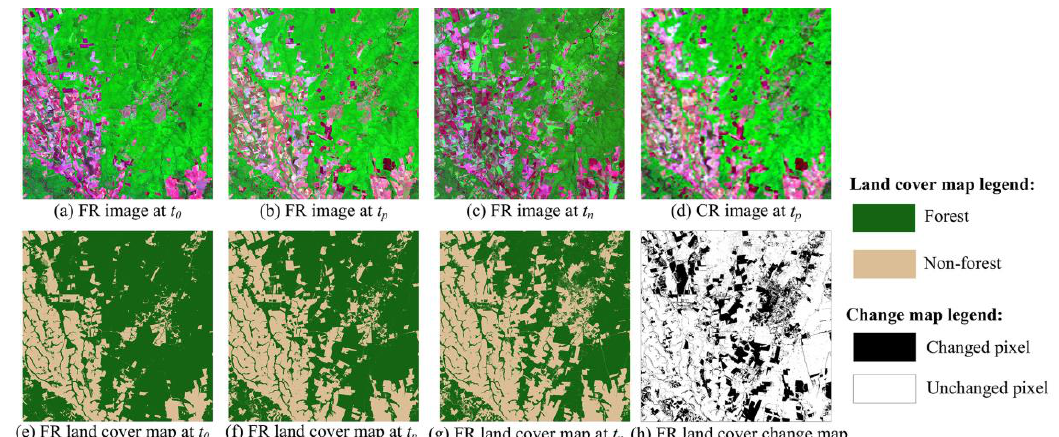
Figure 5. The FR images, CR image, FR land cover maps, and FR land cover change map used in the forest clearance experiment. The scale factor s was 16. ( a ) FR image at t 0 from Landsat image acquired on 23 July 2001; ( b ) FR image at t p from Landsat image acquired on 21 July 2003; ( c ) FR image at t n from Landsat image acquired on 5 June 2004; ( d ) CR image at t p from MODIS image acquired on 21 July 2003; ( e ) FR land cover map at t 0 ; ( f ) FR land cover map at t p (reference land cover map); ( g ) FR image at t n ; ( h ) FR land cover change map that was produced by comparing ( e – g